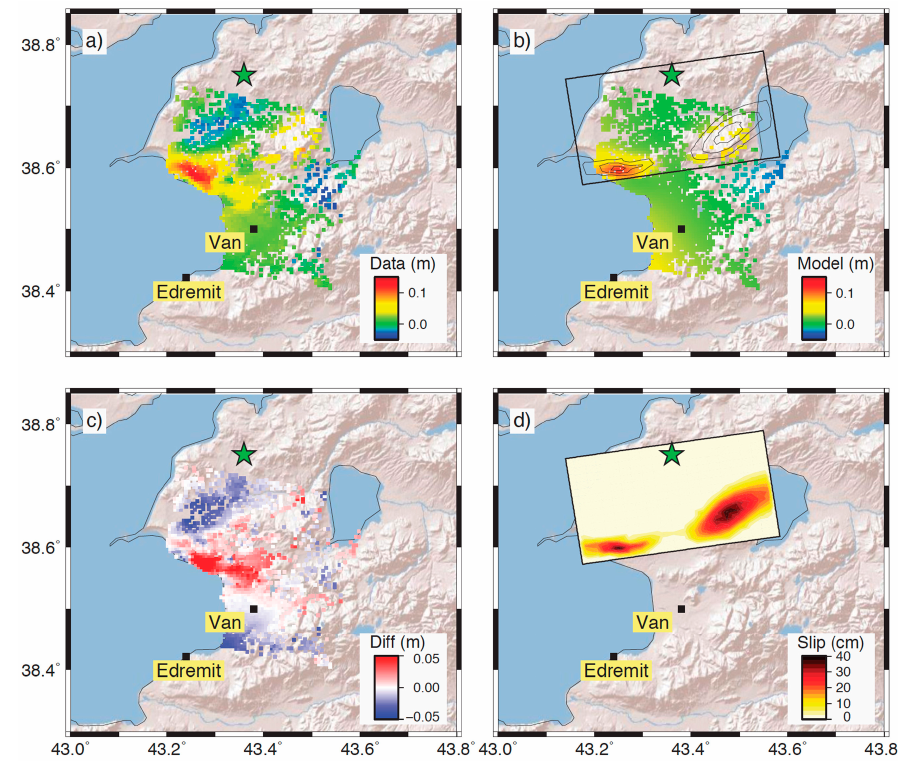
Figure 10. Post-seismic InSAR data and modeling (17-days temporal baseline): ( a ) subsampled data (step of 500 m, 1590 data points) computed from the difference between images CSK3 and TSX2 (see text for details); ( b ) modeled LOS displacements and the fault afterslip contour each 10 cm; ( c ) residuals (observed minus modeled data); and ( d ) related afterslip distribution. The green star is the mainshock epicenter.